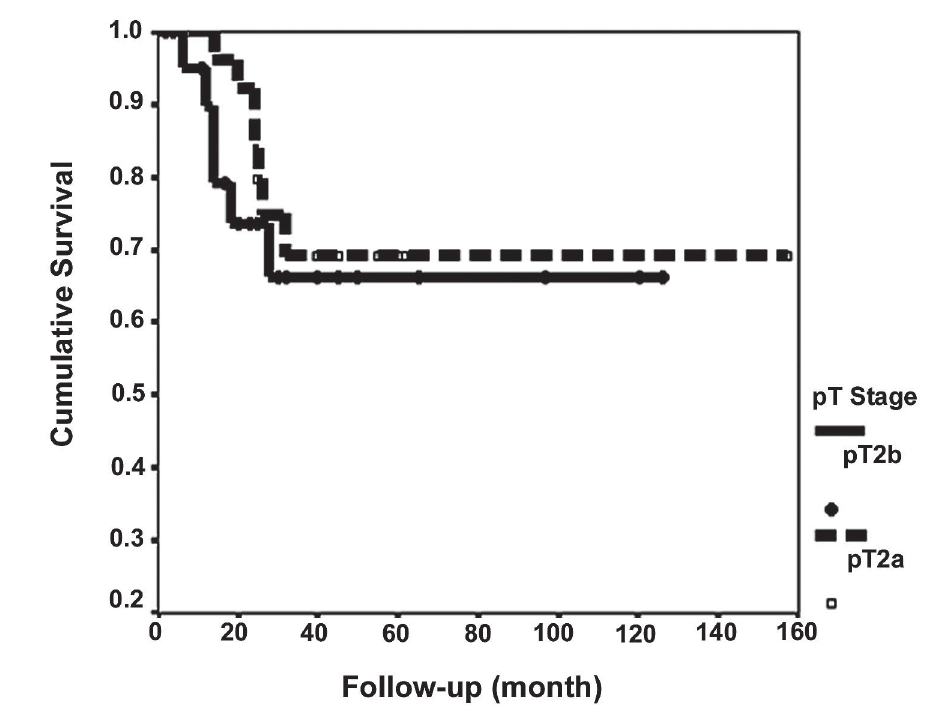
Figure 2 – Kaplan-Meier curve demonstrating progression-free survival in patients with pT2a and pT2b bladder